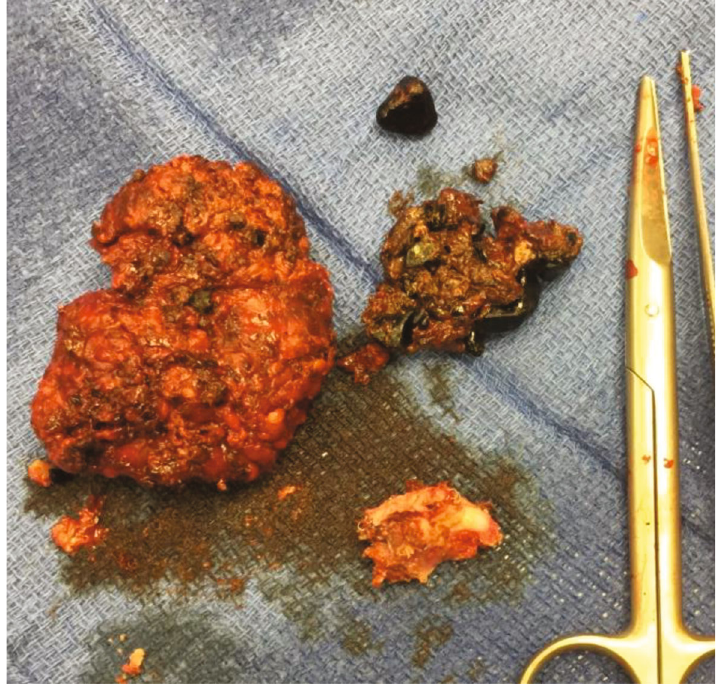
Figure 3: Gallbladder specimen: acute gangrenous and chronic